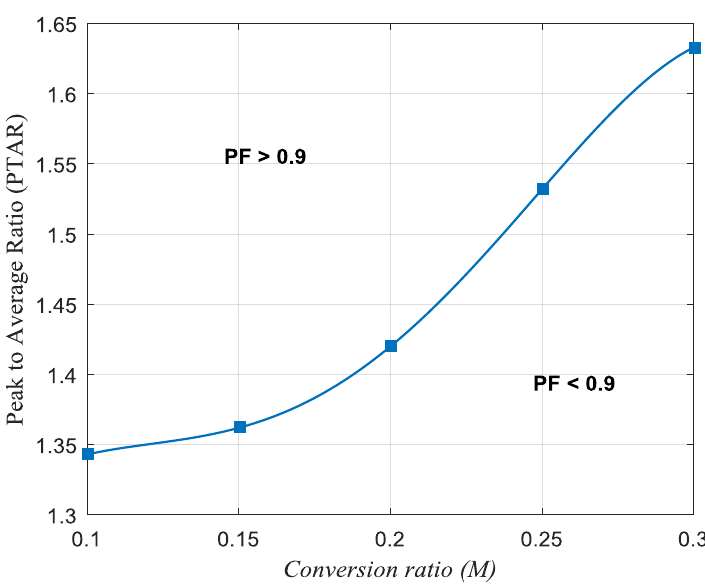
Figure 6. Curve fitted for different values for conversion ratio ( M ) and Peak to Average Ratio (PTAR).